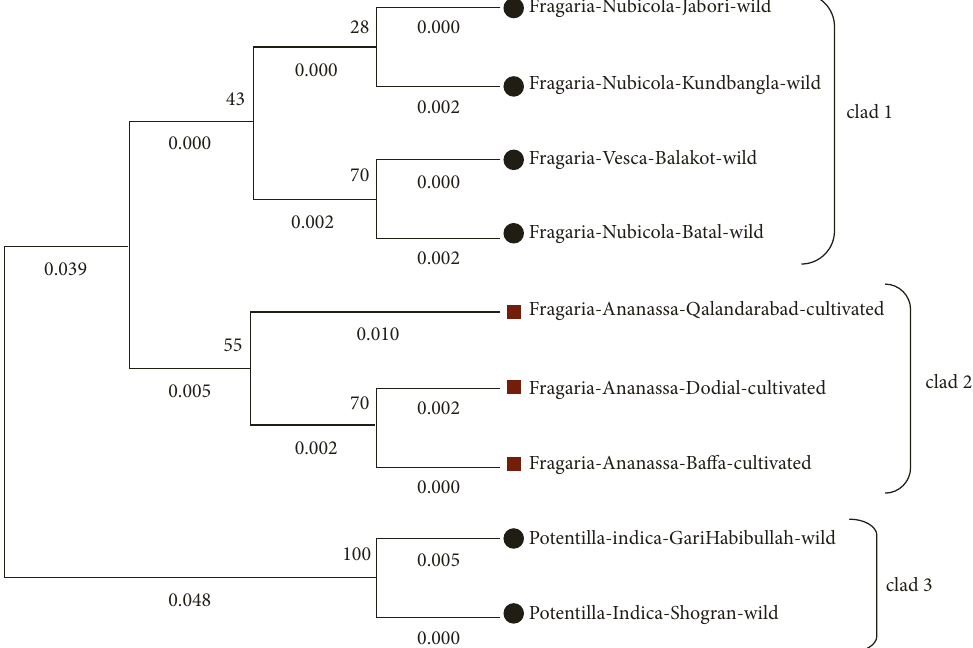
Figure 5: Molecular phylogenetic tree of wild and cultivated species of Fragaria with the ITS2 marker through the maximum likelihood method.